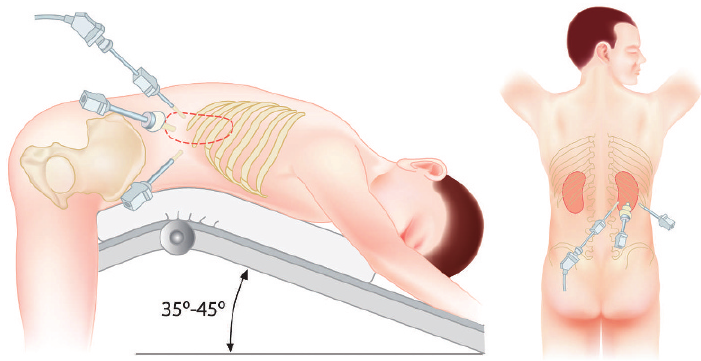
Figure 2 - Prone position. The patient is placed in a half-jackknife position with the hip, joints and the knees bent 75–90 ˚ . Trocar disposition and camera entrance